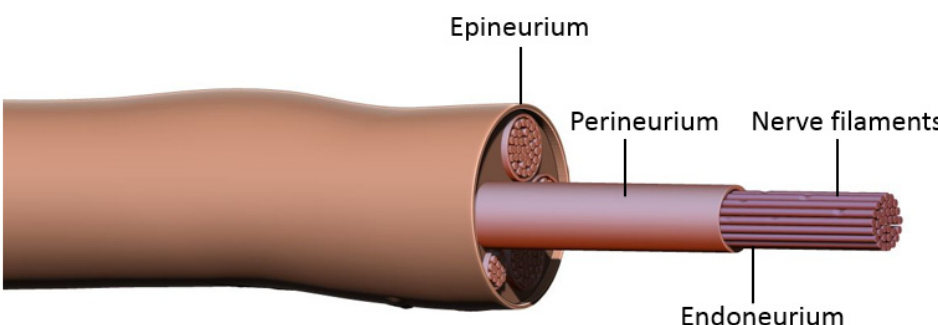
Figure 1. Peripheral nerve structure. Each axon is enveloped by endoneurium and Schwann cells. Groups of these nerve filaments are organized into fascicles by perineurium, and these fascicles are finally sheathed in epineurium to form a peripheral nerve.